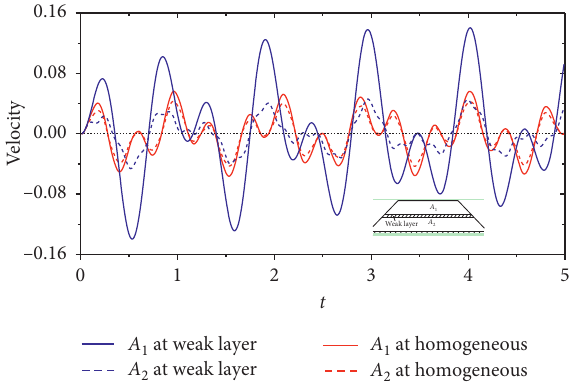
Figure 12: Variation in generalized energy with time.